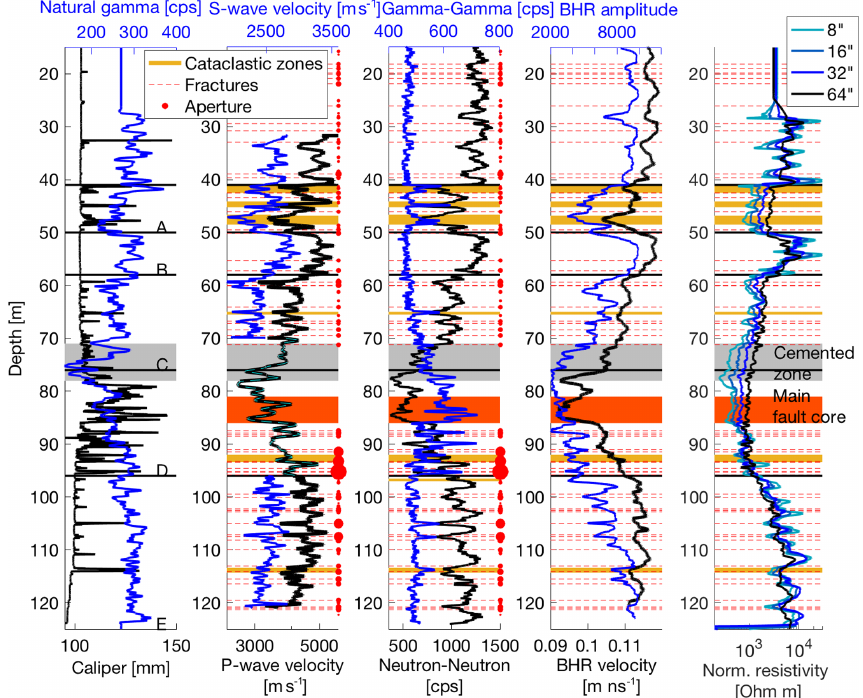
Figure 6. Representative selection of borehole log data comprising from left to right caliper, natural gamma, sonic velocity, neutron– neutron and gamma–gamma, BHR direct-wave velocity, and amplitude as well as normal resistivity logs with a separation of 8in. (0.2m), 16in. (0.4m), 32in. (0.8m), and 64in. (1.6m). The brittle deformation features interpreted from the OTV data (Egli et al., 2018) are super- imposed on the log data. The sizes of the circles are indicative of the relative fracture apertures. Zones A through E refer to zonation shown in Fig.